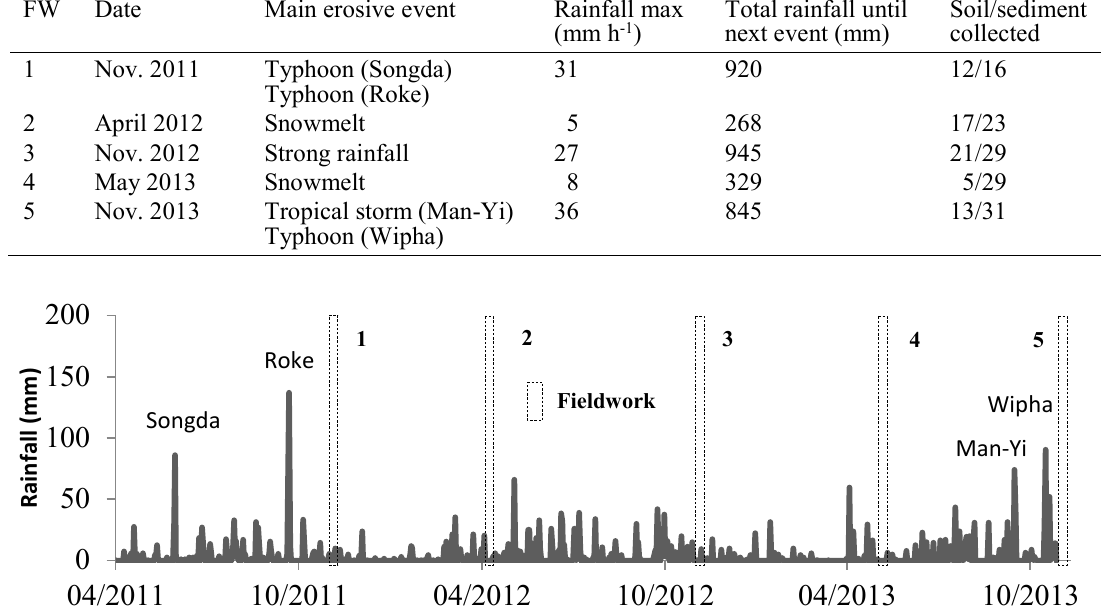
Table 1 Summary of the fieldwork (FW) campaigns and the rainfall characteristics recorded during the study period.